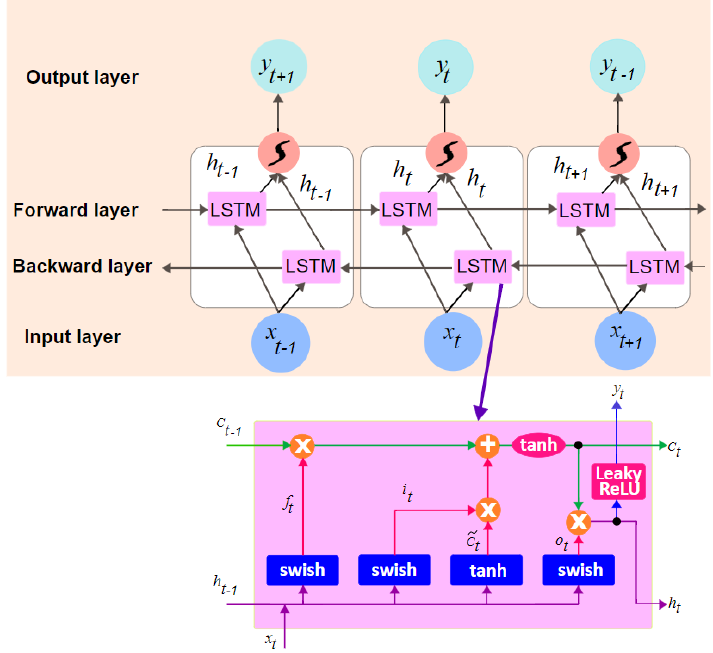
Figure 4. Single LSTM cell and Bi-LSTM of the proposed model.